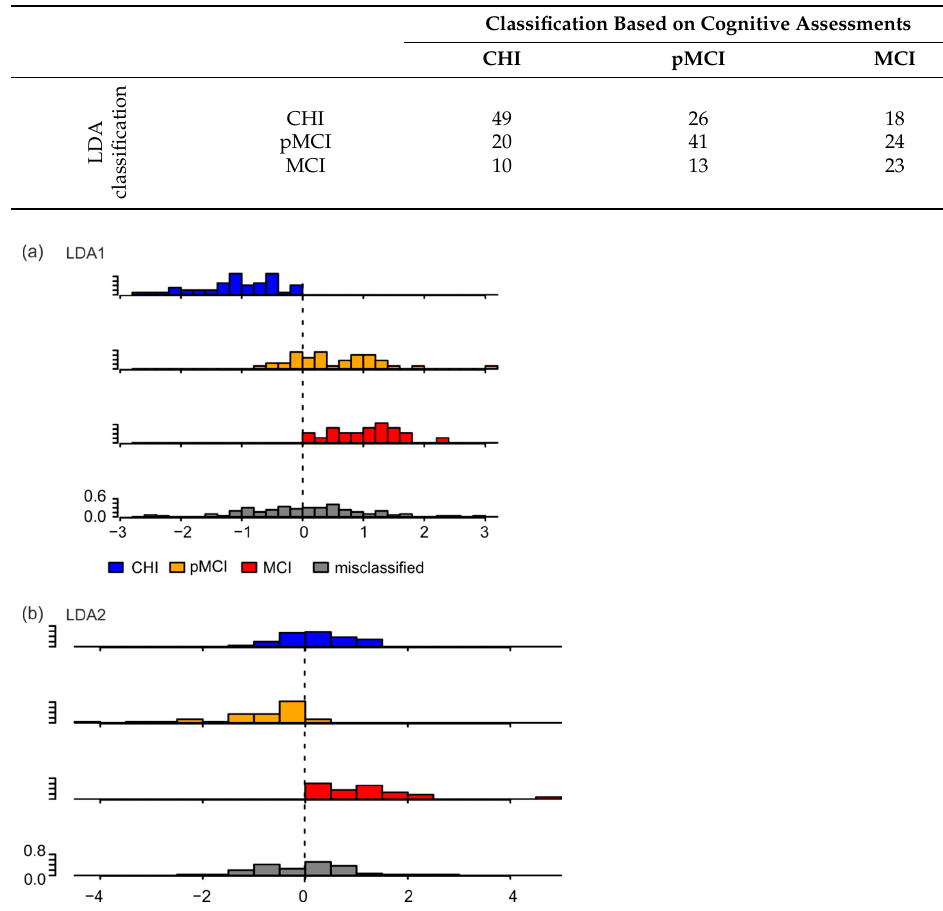
Table 6. Confusion matrix of classification.